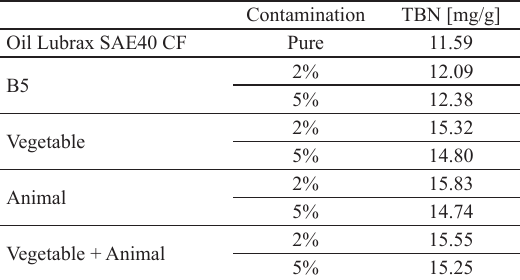
Table 7. TBN value for each sample tested.